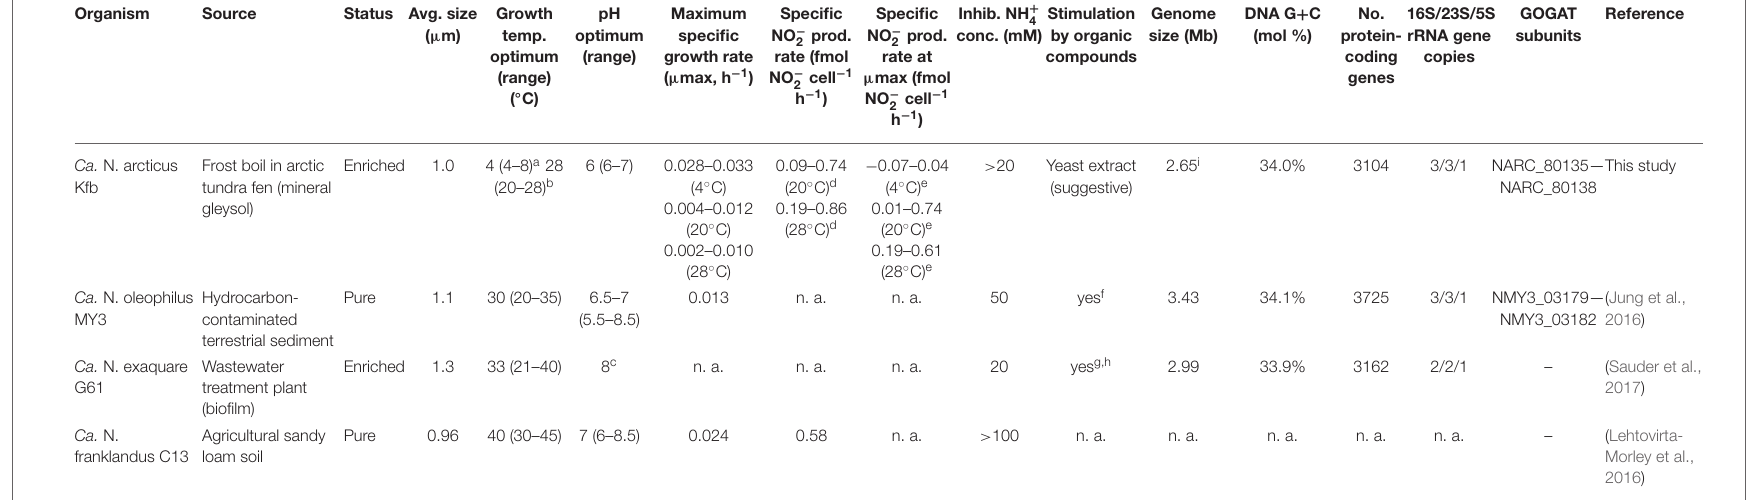
TABLE 1 | Characteristics of Ca. N. arcticus Kfb and other cultivated members of candidate genus Nitrosocosmicus.